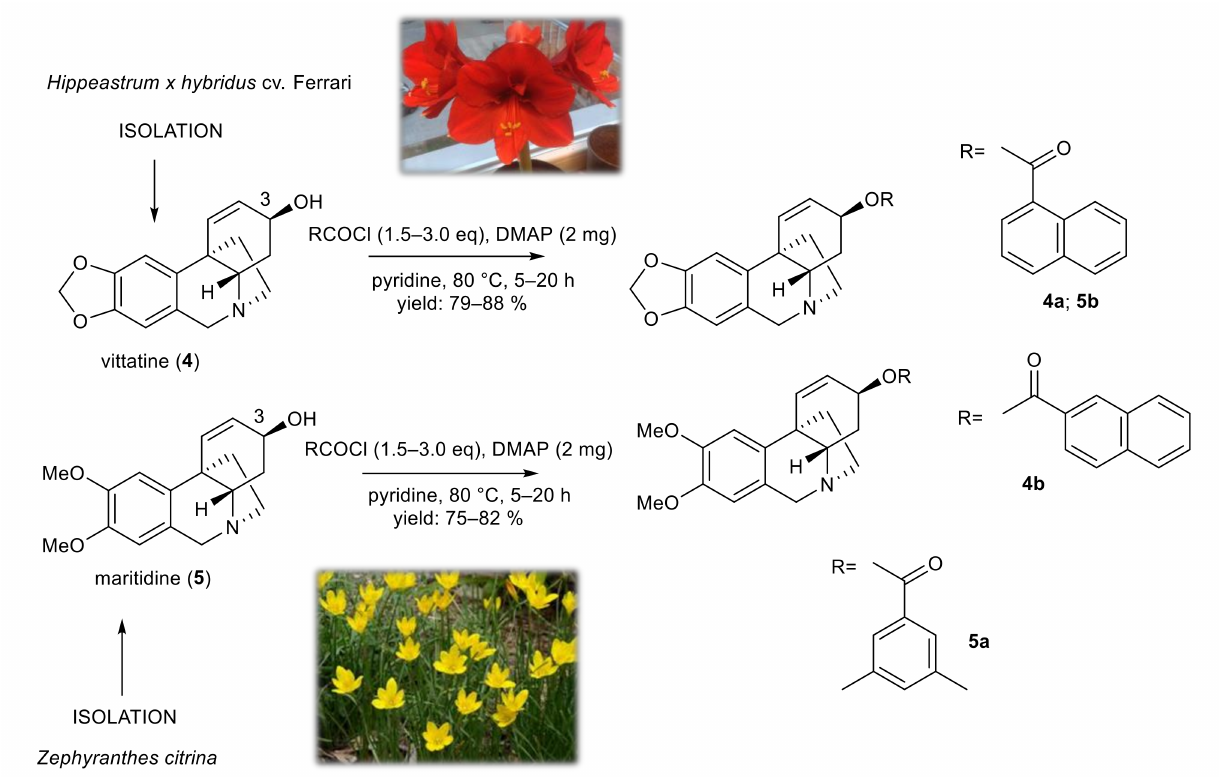
Figure 3. Chemical procedures affording vittatine ( 4a , 4b ) and maritidine derivatives ( 5a,5b